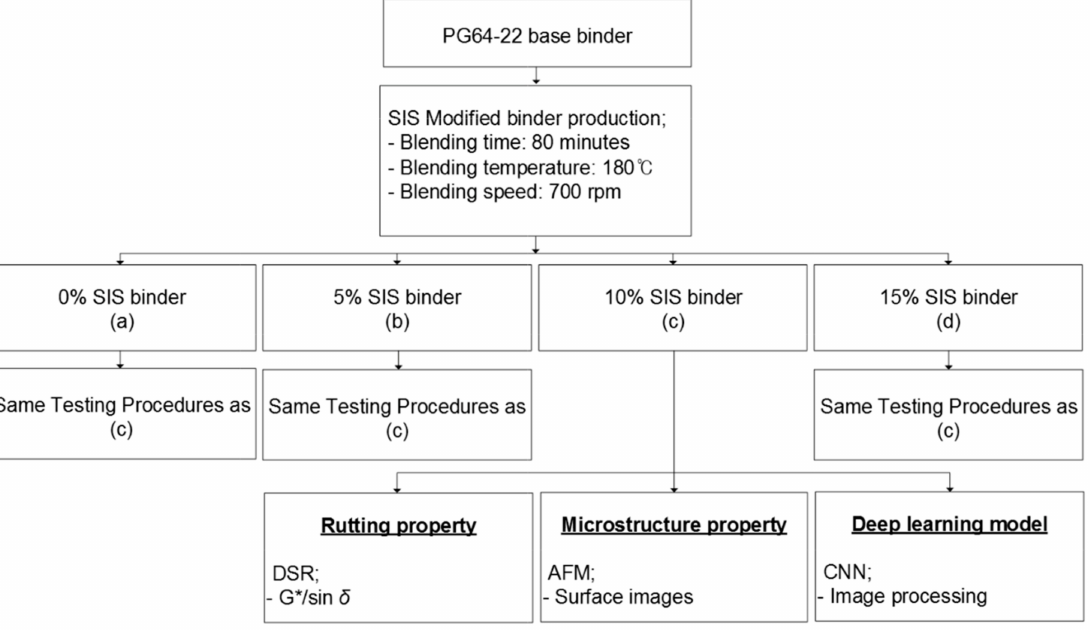
Figure 1. Flow chart of experimental design procedures.